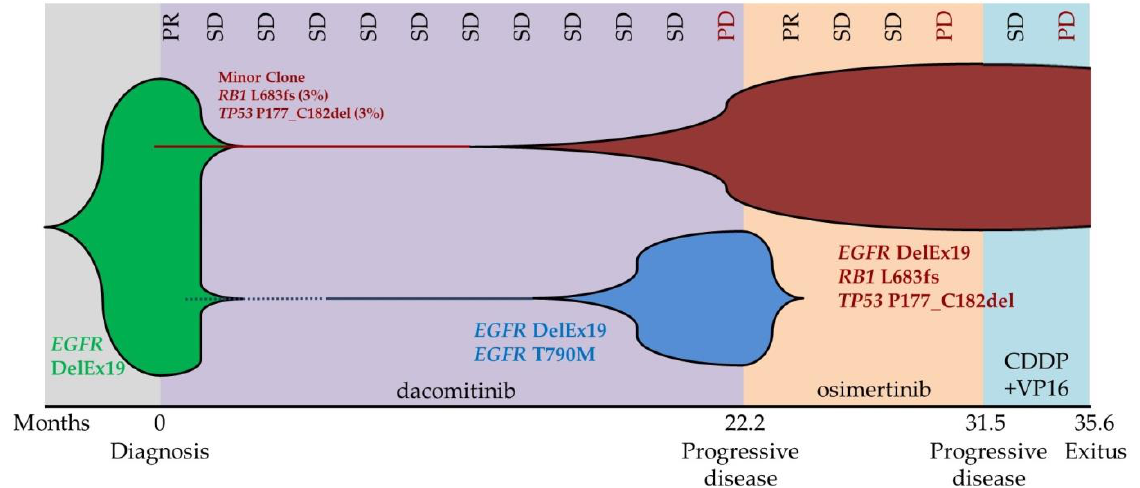
Figure 2. Clonal architecture of the disease was inferred through NGS analysis of FFPE and LB samples. The bottom horizontal axis represents the time from diagnosis and the subsequent treatment lines. The upper horizontal axis includes the results of the CT scans. PR: Partial Response; SD: Stable Disease; PD: Progressive Disease; CDDP + VP16: Cisplatin + Etoposide.